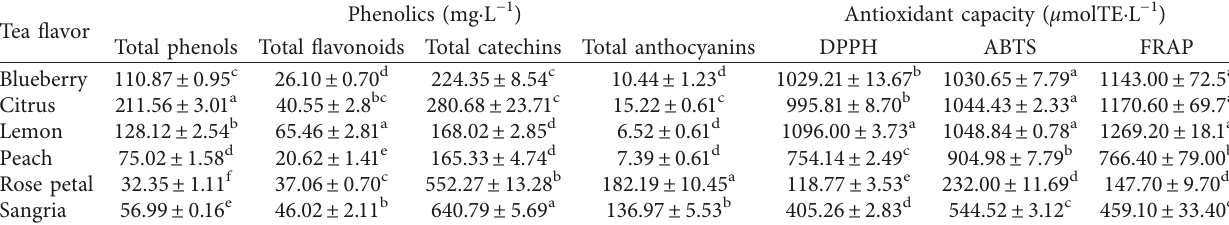
Table 4: Nutraceutical properties of ready-to-drink flavored-colored commercial teas. Phenolics (mg · L − 1 Tea flavor